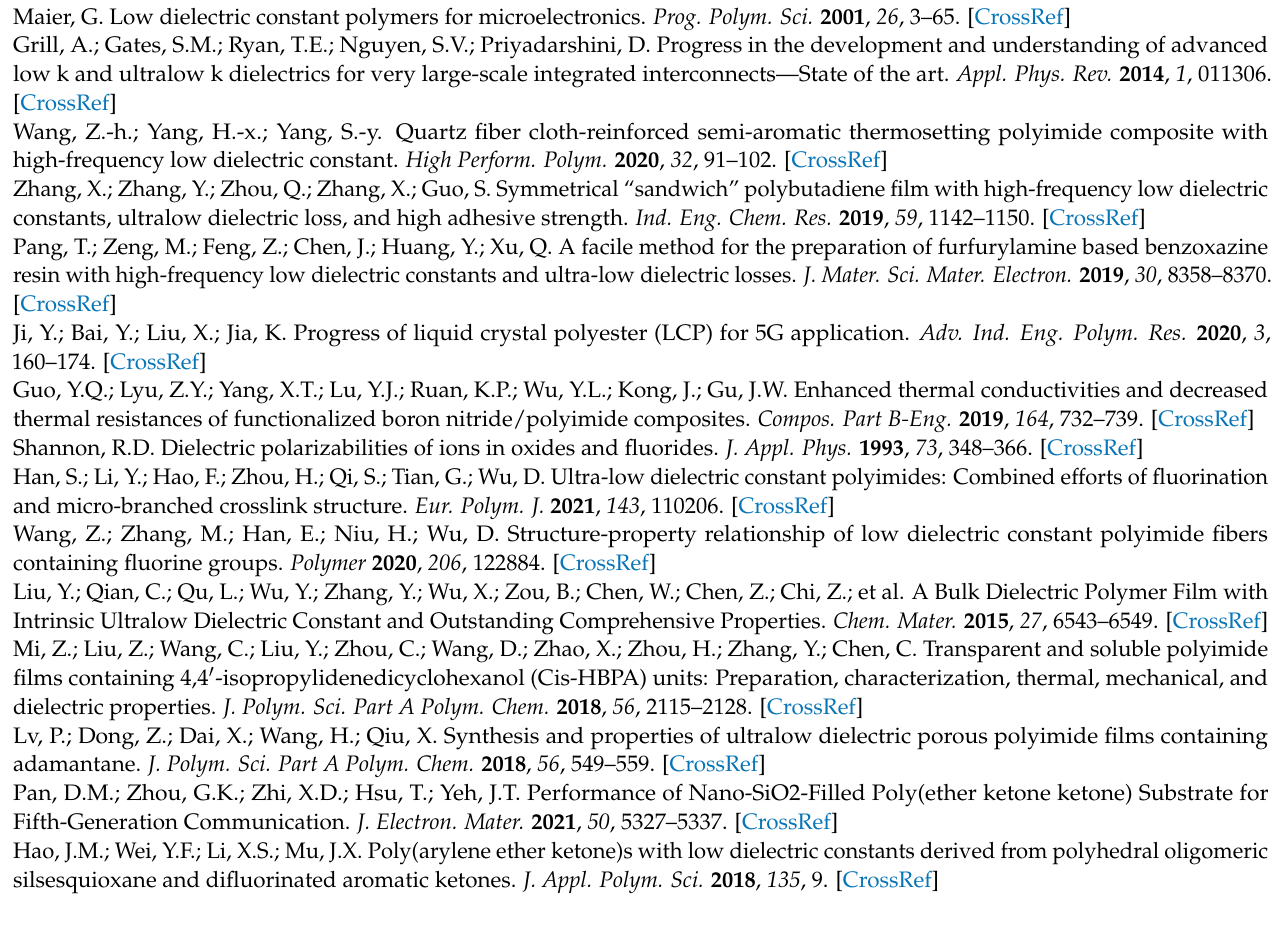
DFBCH monomer. Figure S4. 1H-NMR characterization spectrum of BFBB monomer (500 MHz, Chloroform-d): δ = 8.14 ~ 7.88 (m, 1H), 7.21 ~ 7.04 (m, 1H), 3.45 ~ 3.21 (m, 1H), 2.12 ~ 1.58 (m, 2H). Figure S5. FT-IR spectrum of BFBB monomer. Figure S6. MS spectrum of BFBB monomer. Figure S7. WAXD spectra of copolymer